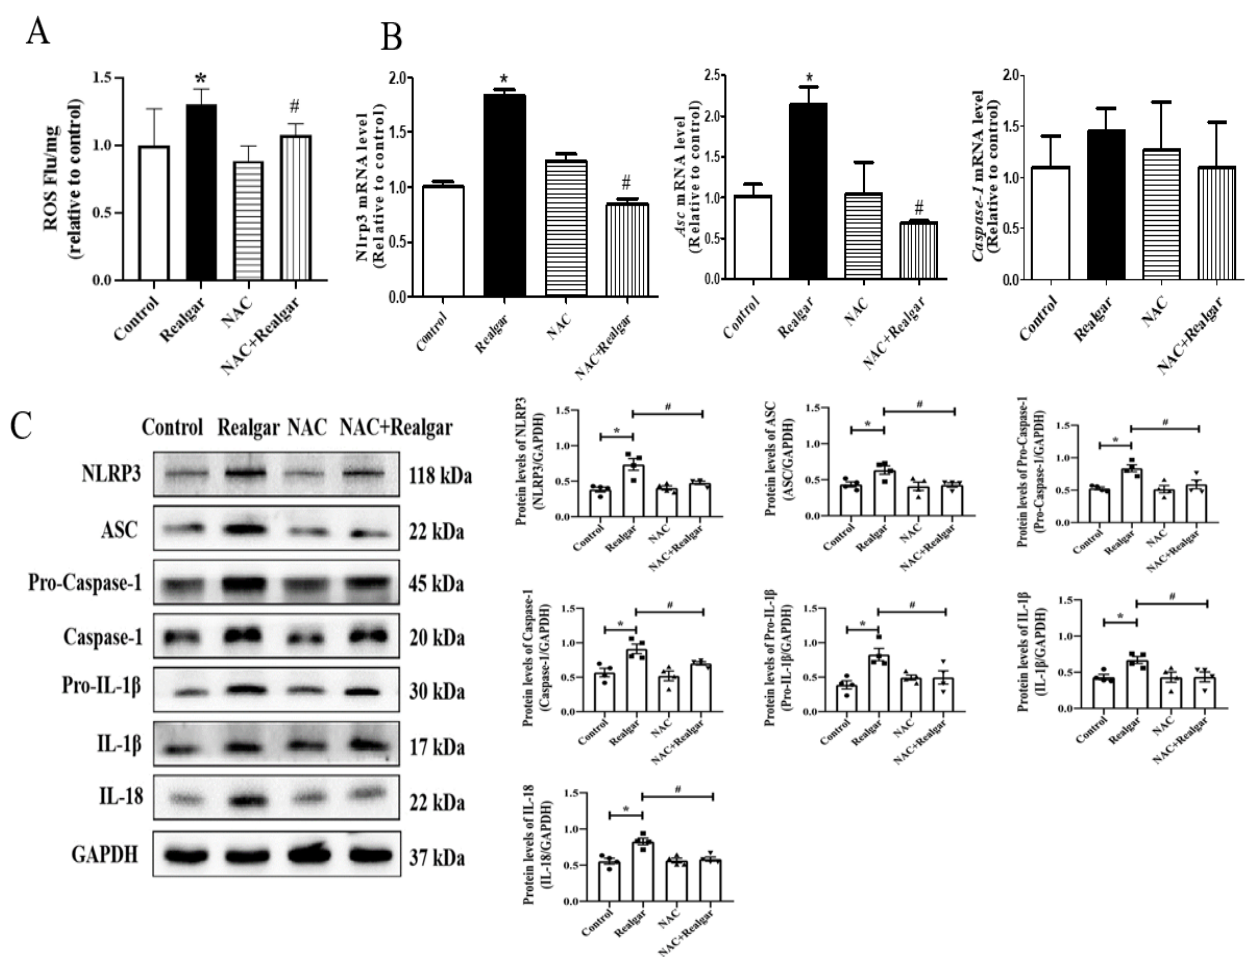
Figure 5. ROS is involved in realgar-induced NLRP3 inflammasome activation in mouse livers. ( A ) The intracellular ROS level in mouse livers was measured by the DCFH-DA method (Ex 502 nm, Em 530 nm, n = 6). ( B ) The relative mRNA levels of Nlrp3 , Asc , Caspase-1 were evaluated by RT-qPCR and normalized the data to Gapdh ( n = 3). ( C ) Representative Western blots showing the expressions of NLRP3 inflammasome-related proteins and quantitative analysis using image J software. The gray value of the bands was normalized to GAPDH ( n = 4).Data are presented as mean ± SEM. * p < 0.05, compared with control group; # p < 0.05, compared with realgar-treated group.